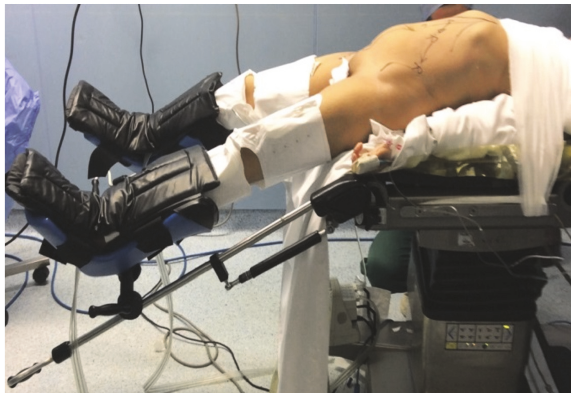
Figure 1: Modified Lloyd-Davis position.